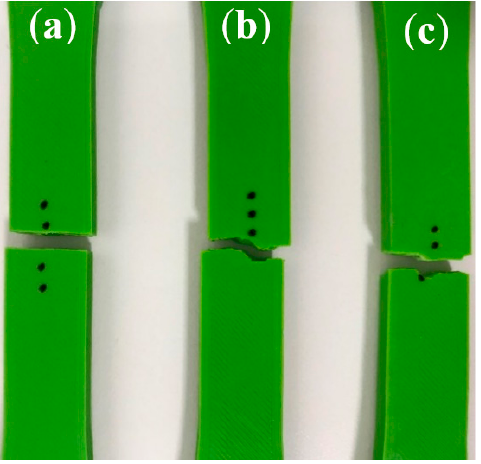
Figure 5. Fractured samples ( a ) perpendicular to the axis, 0° ( b ) 45° ( c ) along the axis, 90° [38].